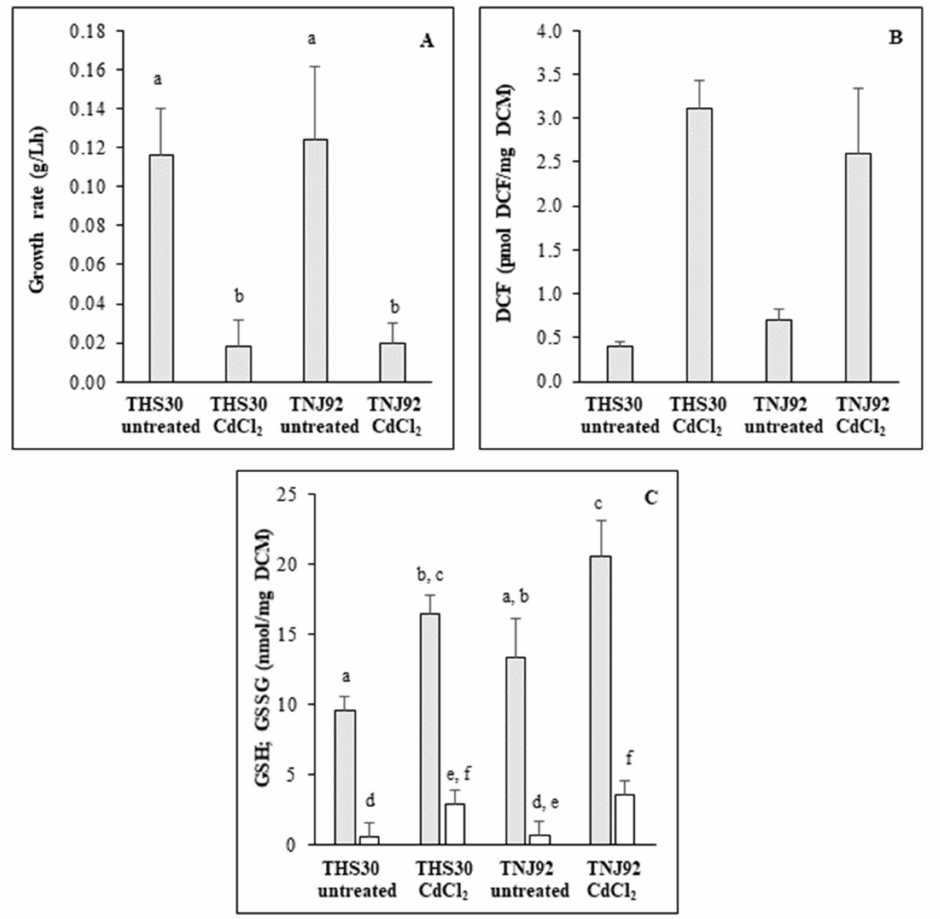
Figure 1. Physiological consequences of cadmium treatment on A. nidulans . The ∆ atfA mutant (TNJ92) and the reference (THS30) strains were treated with 0.2 mM CdCl 2 . Stress tolerance was characterized with the growth rate of the cultures ( A ). Redox imbalance caused by CdCl 2 treatment was characterized with DCF-test ( B ). GSH (grey) and GSSG (white) content of treated and untreated cultures were recorded with the DTNB-GR assay ( C ). Mean ± SD. Values (n = 3) are presented. According to the two-way-ANOVA the CdCl 2 treatment had a significant effect on DCM formation ( p = 0.0000867), DCF production ( p = 0.000003148) as well as on the GSH ( p = 0.00004586) and GSSG ( p = 0.00117) contents of cells. The genotype of the strains had a significant effect only on GSH content ( p = 0.0097778), but the genotype did not influence the effect of CdCl 2 treatment ( p = 0.994) even in this case. Means of the same variable marked with a common letter are not significantly different by the Tukey post-hoc test at the p = 0.05